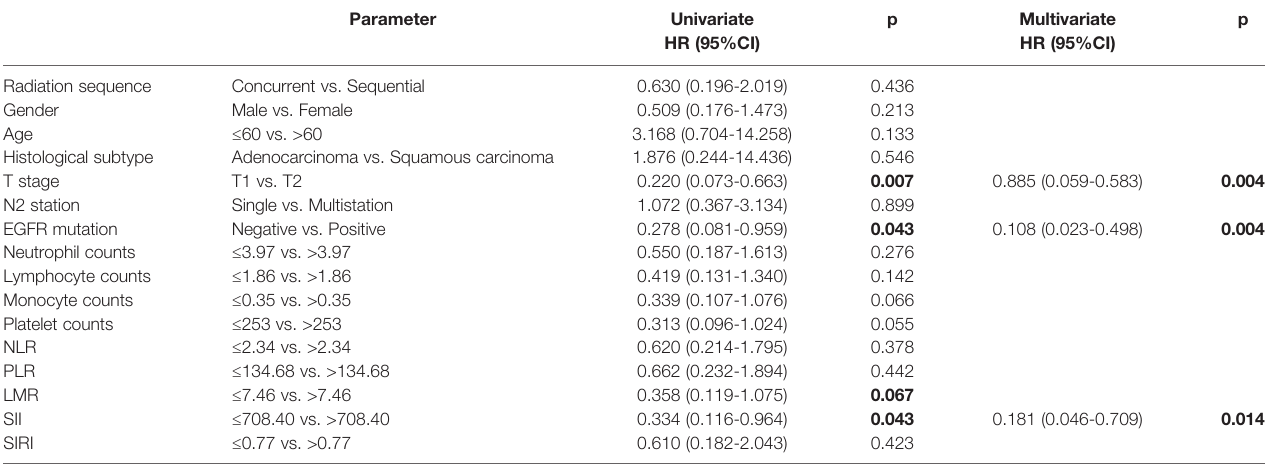
TABLE 2 | Univariate and multivariate analyses of